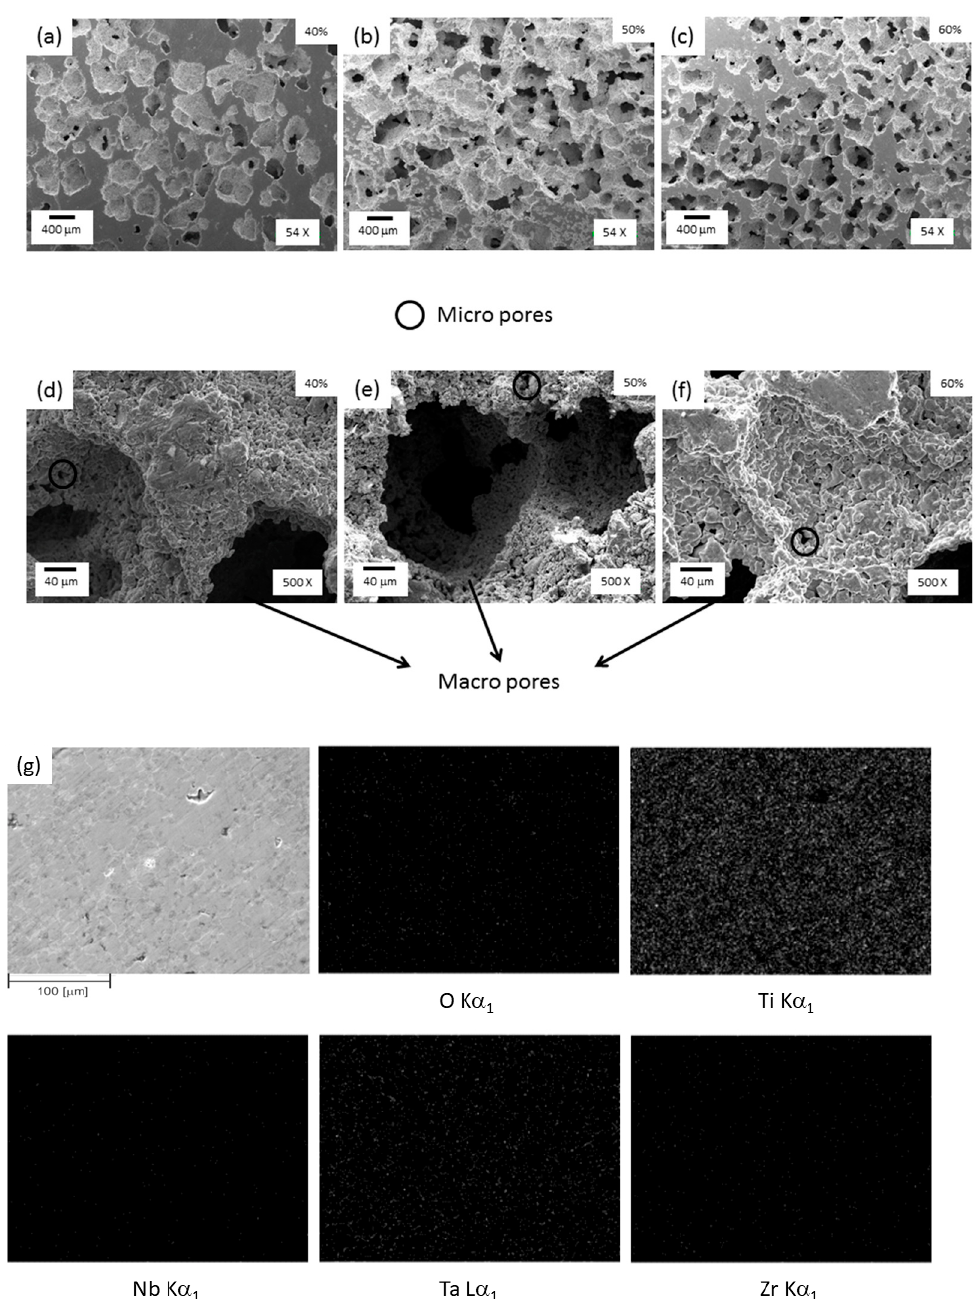
Figure 5. SEM images of foams with ( a , d ) 40, ( b , e ) 50, and ( c , f ) 60% porosity with different magnifications and ( g ) EDS analysis for the 60% porosity foam sample.